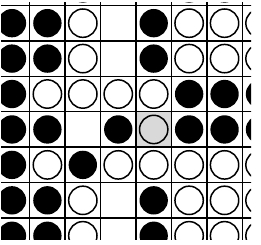
Figure 54. BLACK recaptures.